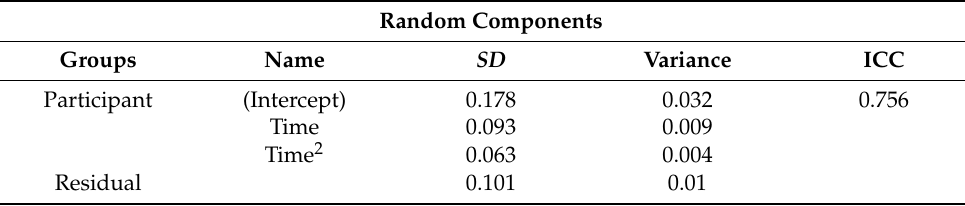
Table 4. Random components of the final